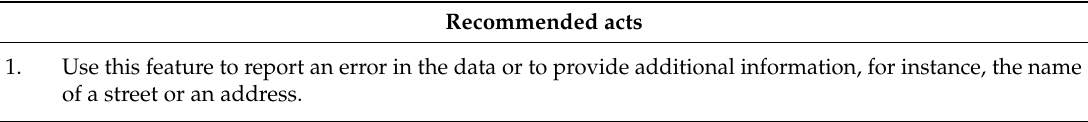
Table 1. The usages of OpenStreetMap (OSM) Notes.